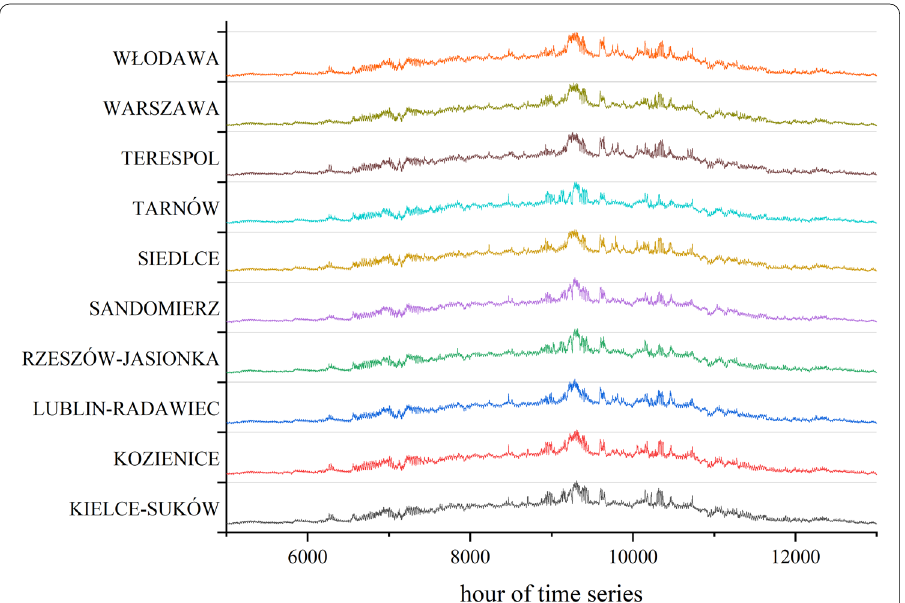
Fig. 8 Time series—winter season 2005/6 (in Fig. 8 marked by dashed lines). Occasional values can be seen to reach 100% of nominal heat demand or exceed it, and respective demand peaks to mutate from case to case. X axis denotes consecutive hours of the dataset; Y axis marks cities. For each city the scale is from 0 to 1. Time series has been generated based on ANN model presented in earlier section